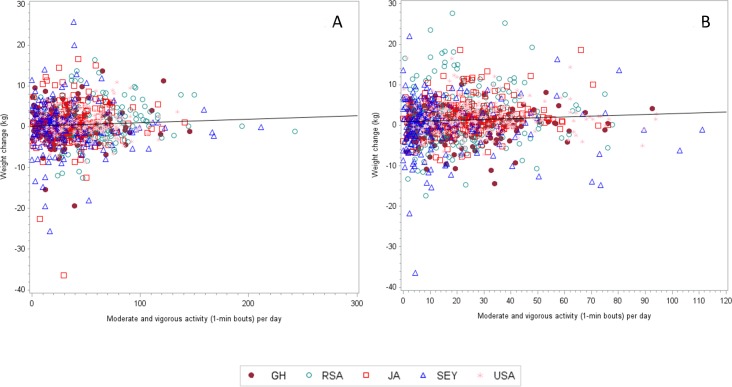
The correlation coefficient (adjusted for age and follow up time) between weight change and MVPA (1-min bouts) for men is 0.03459 (n = 869, p = 0.3091).